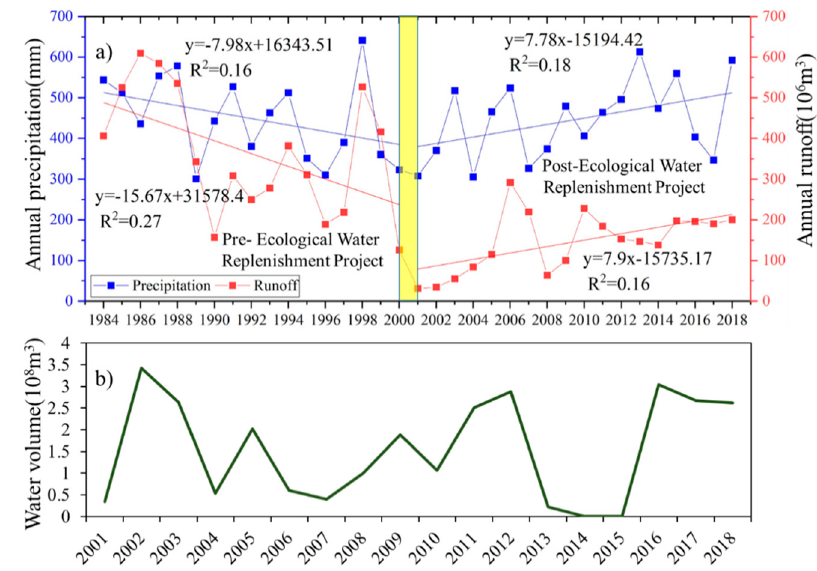
Figure 7. Time series of annual ( a ) runoff, precipitation, and ( b ) replenishment volume in the Zhalong wetland.